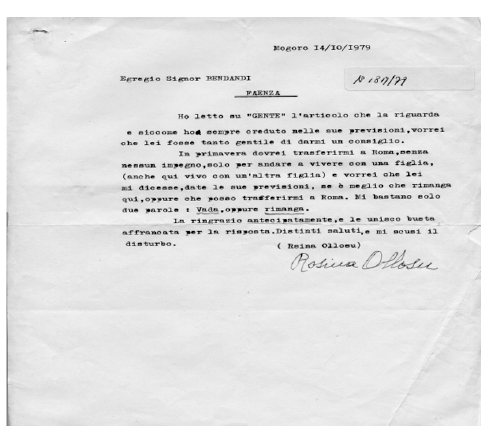
Fig. 8. The writer is a lady from Mogoro, in Sar- dinia; after reading an article in the magazine called Gente that reminded her of the seismologist and his forecasting capacities, renewing his esteem for him, she asked him for some advice on whether or not to move to Rome «I only need two words: Go or stay». This is the last letter received by Bendandi: the date is October 1979, around sixty years had passed since his first